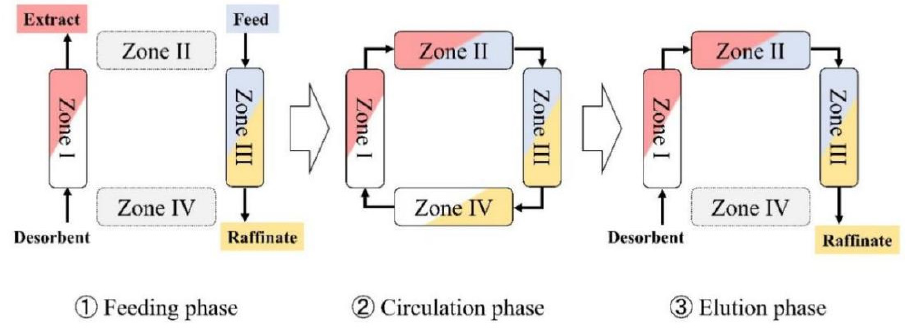
Figure 14. Schematic diagram of the SSMB process.